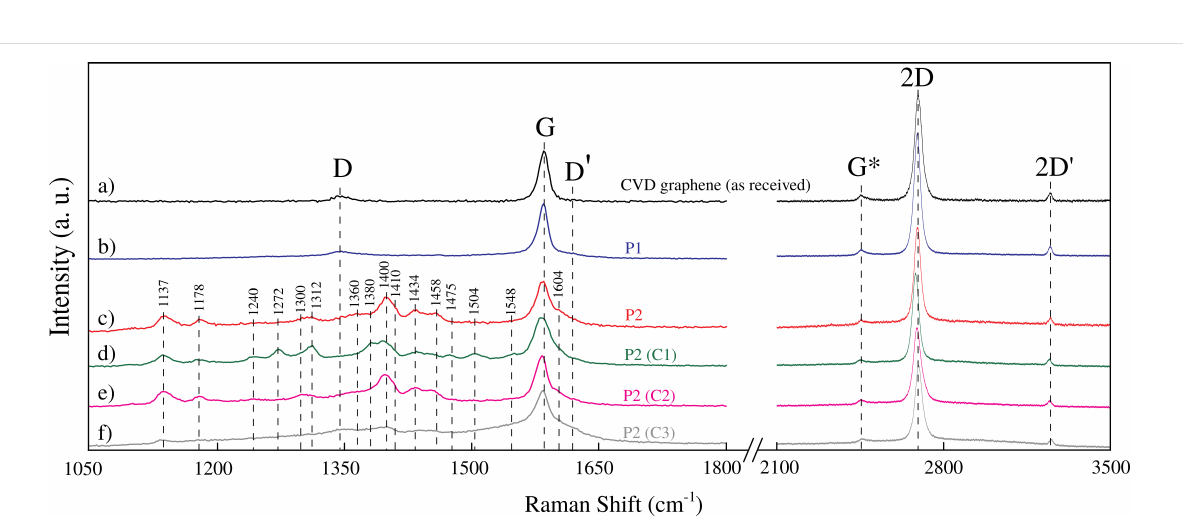
Figure 3: Raman spectra of CVD graphene devices (from top to bottom): graphene as-received; graphene device fabricated by procedure P1 (imme- diately after lift-off); graphene device fabricated by procedure P2 (immediately after lift-off); graphene device fabricated by procedure P2 and after cleaning with NMP (C1); graphene device fabricated by procedure P2 and after cleaning with DMF (C2); and graphene device fabricated by proce- dure P2 and after cleaning with H 2 /Ar annealing